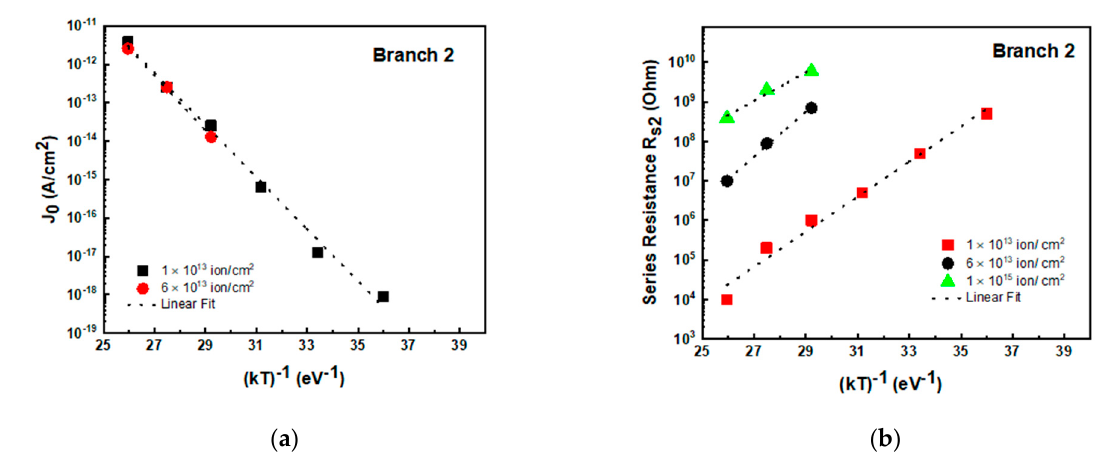
Figure 10. Pre-exponential factor (J 0 ) for diode D 2 obtained by the fit of I–V characteristics as a function of 1/kT for different fluence-irradiated diodes obtained by using the two-diode structure ( a ). Series resistance versus 1/kT for the same diode D 2 ( b ).